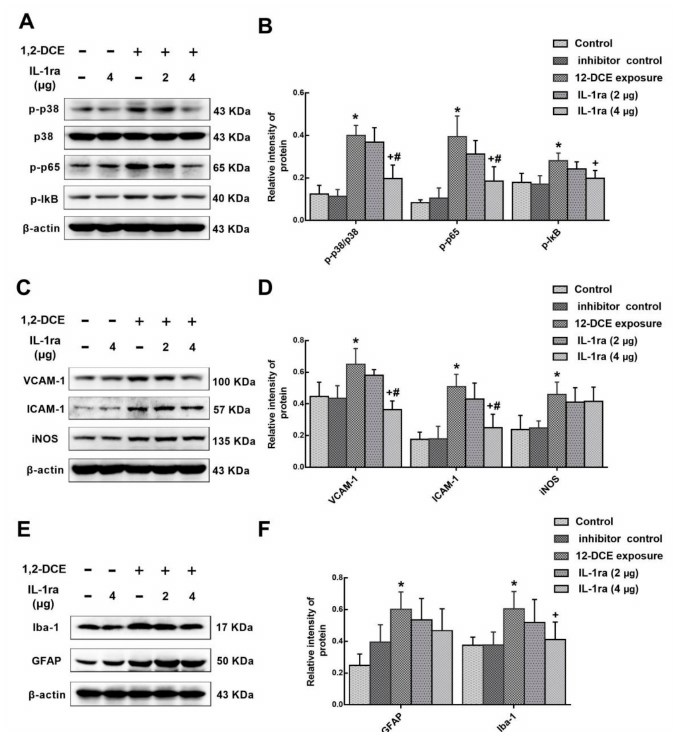
Figure 8. Involvement of IL-1ra in expression of p-p38, p-p65, p-I κ B, VCAM-1, ICAM-1, iNOS, Iba-1 and GFAP in 1,2-DCE-intoxicated mice. ( A , C , E ) Representative images of Western blot analysis. ( B , D , F ) Graphs show the densitometric quantitation of p-p38, p-p65, p-I κ B, VCAM-1, ICAM-1, iNOS, Iba-1 and GFAP, which were normalized to the intensity of β -actin. Data expressed as mean ± SD are the results of five independent experiments and analyzed by one-way ANOVA. Significant di ff erence is defined as p < 0.05, and *, vs. control group; + , vs. 1,2-DCE poisoned group; # vs. low dose intervention